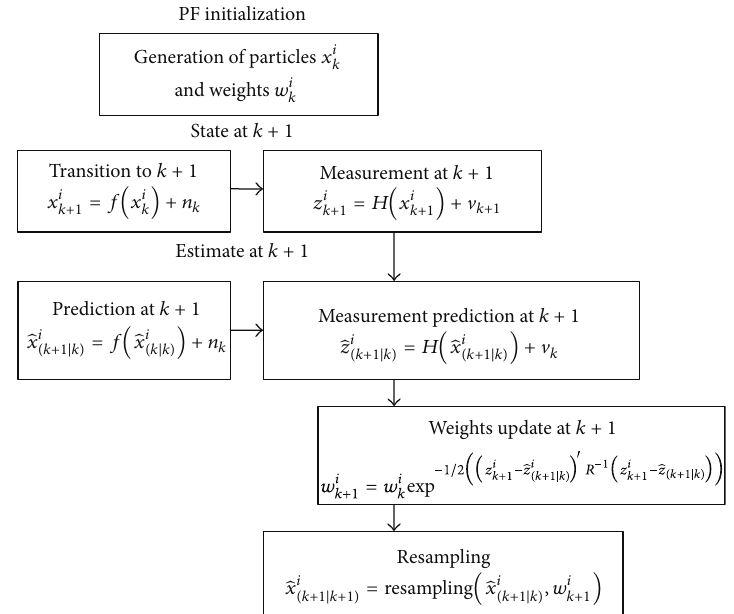
Figure 4: Particle filtering